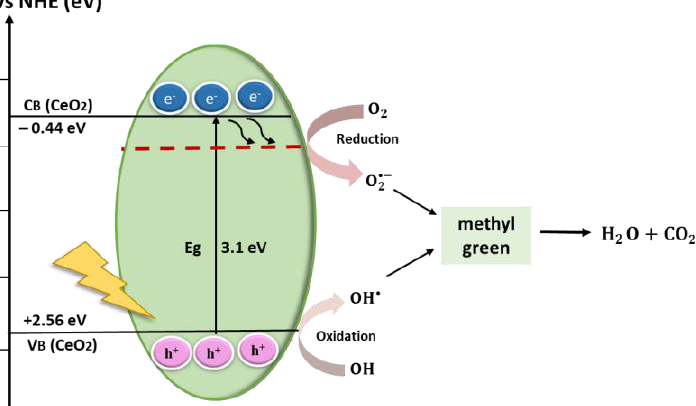
Figure 12. The proposed mechanism of Mn-doped porous ceria in the decolorization of MG dye with the assumption that all Mn ions were incorporated in the lattice of CeO 2 .